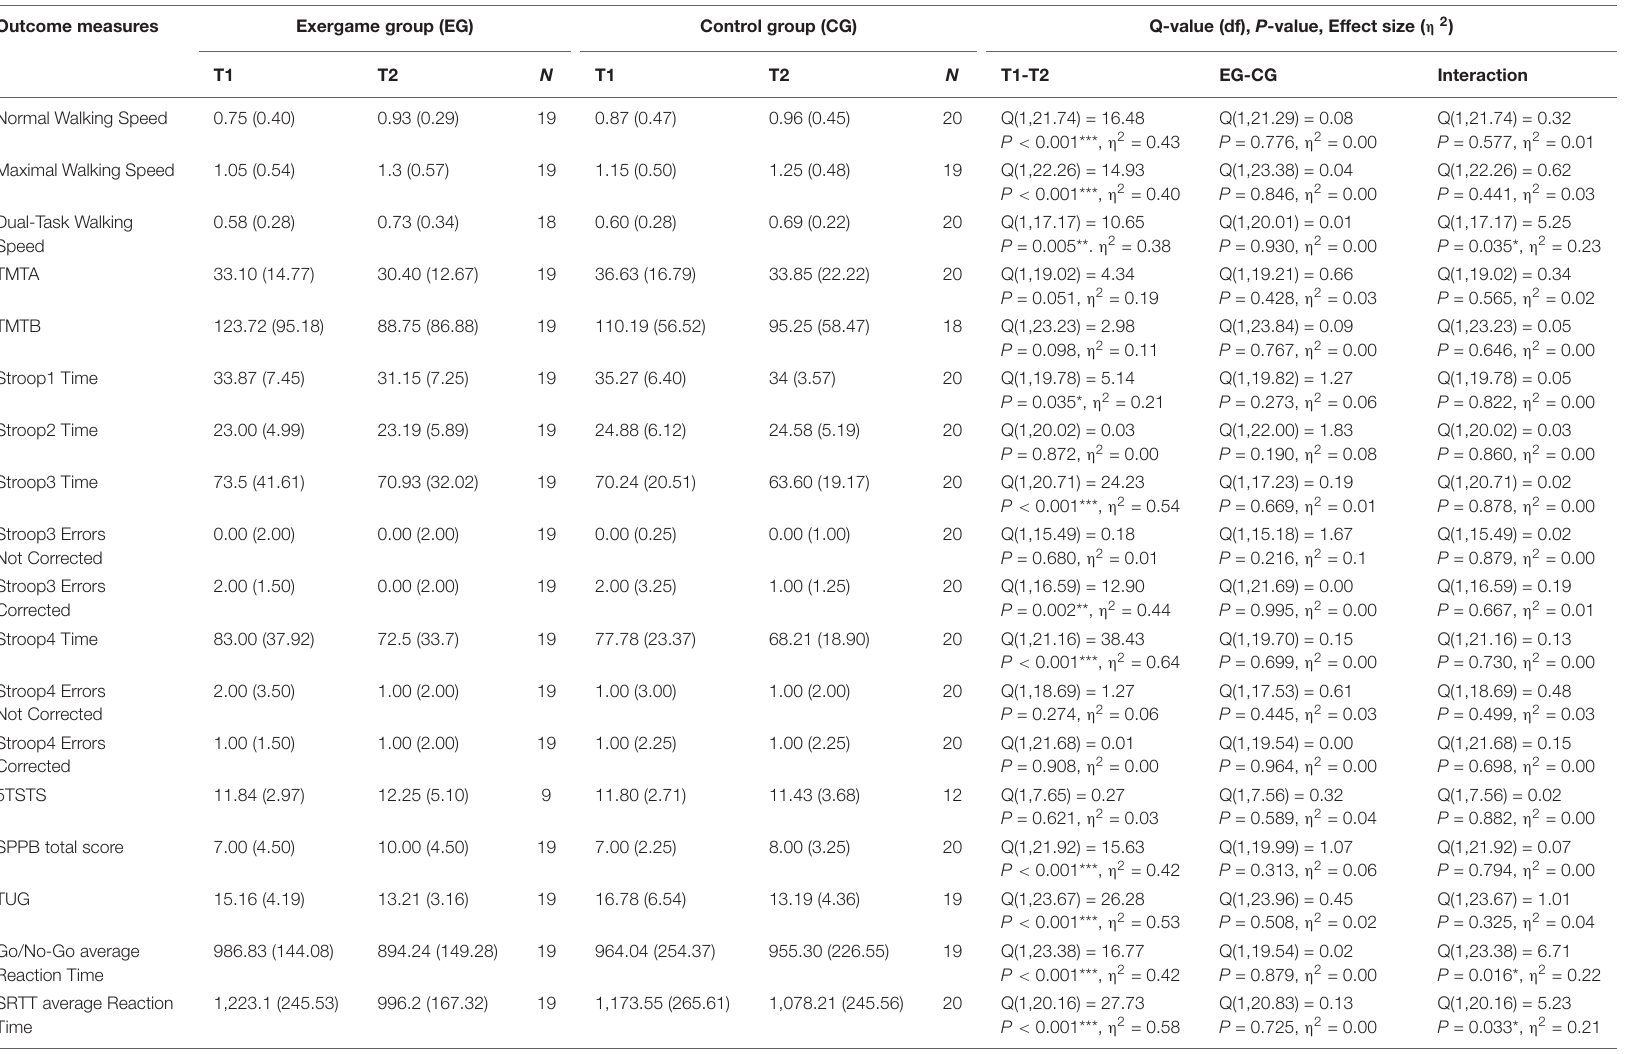
TABLE 3 | Results of each outcome measure across groups and